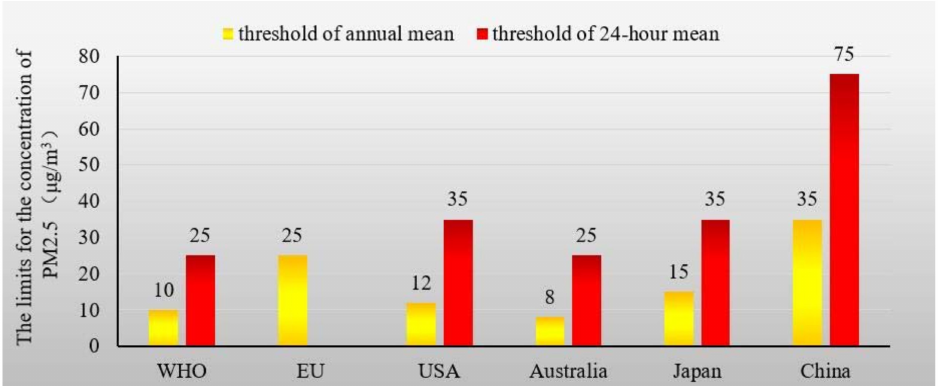
Figure 1. International limits for fine inhaled particulate matter with a diameter of 2.5 micrometers (PM 2.5 , µ g/m 3 ) concentration. (Source: Reports from IEACCC (International Energy Agency Clean Coal Centre) and WHO (World Health Organization)